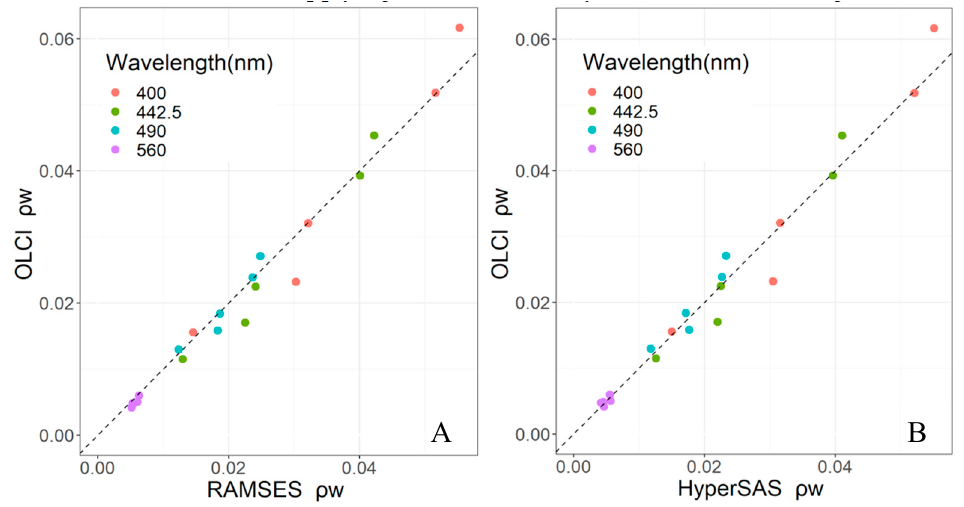
Figure 18. Correlation between OLCI-to-RAMSES ( A ) and OLCI-to-HyperSAS ( B ) water-leaving reflectances at selected wavelengths.